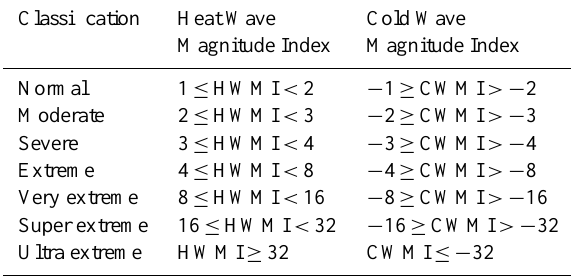
Table 1. Classification of heat and cold wave (i.e. HWMI and CWMI) scale